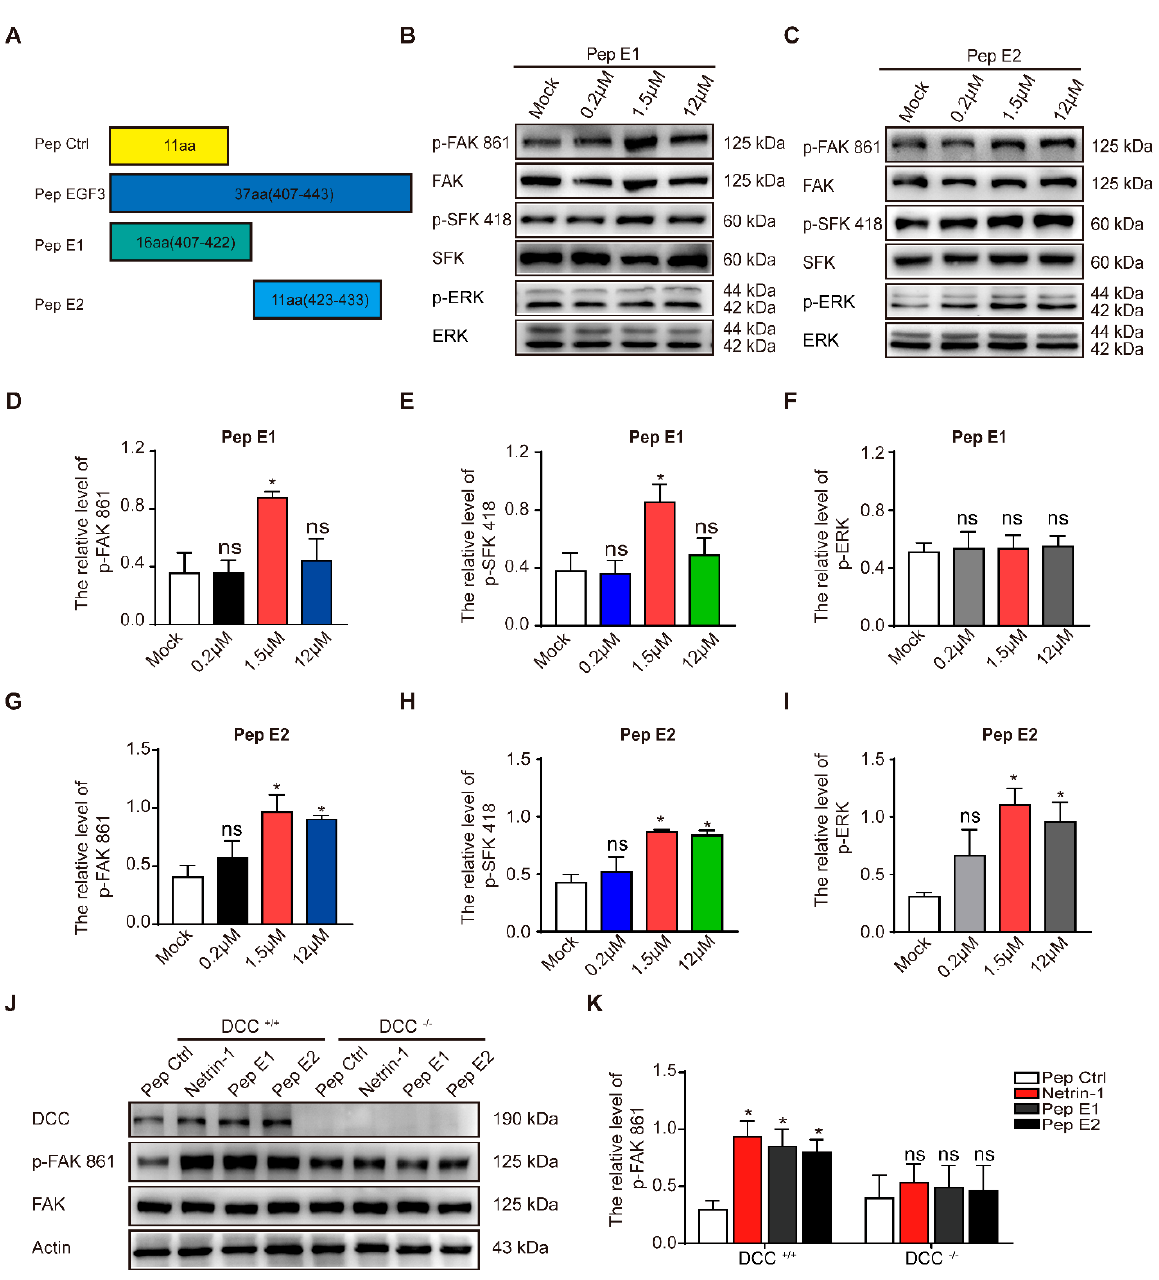
Figure 3. The minimal sequences of the EGF3 domain activates downstream pathways of Netrin-1. ( A ) Illustrations of the peptides. ( B ) Cortical neurons (DIV3) were stimulated with gradient concentrations of peptide E1. Cell lysates were incubated with anti-p-FAK-861, anti-p-SFK-418 and anti-p-ERK-202/204. ( C ) Cultured cortical neurons were treated with gradient concentrations of peptide E2. Lysates were collected and incubated with the indicated antibodies to measure the phosphorylation of FAK, SFK and ERK. ( D – F ) Quantification of the extent of FAK, SFK and ERK phosphorylation induced by peptide E1 in neurons is shown in ( B ). n = 3. ( G – I ) Quantification of the extent of FAK, SFK and ERK phosphorylation induced by peptide E2 is shown in ( C ). n = 3. ( J ) Cortical neurons derived from DCC wild-type and homozygote mutant embryos were stimulated with Netrin-1 or Netrin-1-derived peptides and were lysed. The resulting lysates were subjected to immunoblotting. ( K ) Quantification of FAK PY861 and DCC levels in DCC mutant neurons is shown in ( J ). n = 3. The data are presented as the means ± SEMs. One-way ANOVA was used for all statistical analyses shown in this figure (* p < 0.05; ns, not significant). Details of data analysis are seen in Supplementary Table